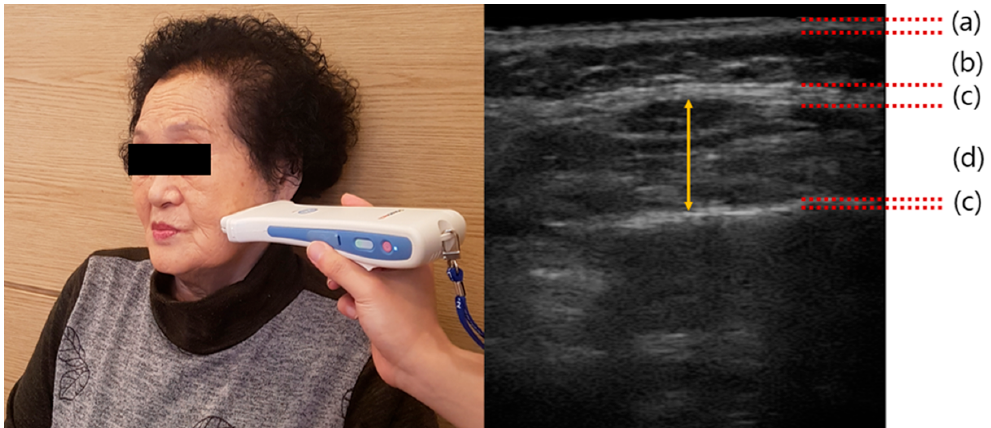
Figure 3. Measurement of masseter muscle thickness. Left panel, image recorded during the actual measurement of masseter muscle thickness and right panel, ultrasound image showing the anatomical structure of the masseter muscle. ( a ) Skin layer; ( b ) Fat layer; ( c ) Masseteric fascia; and ( d ) Masseter muscle.